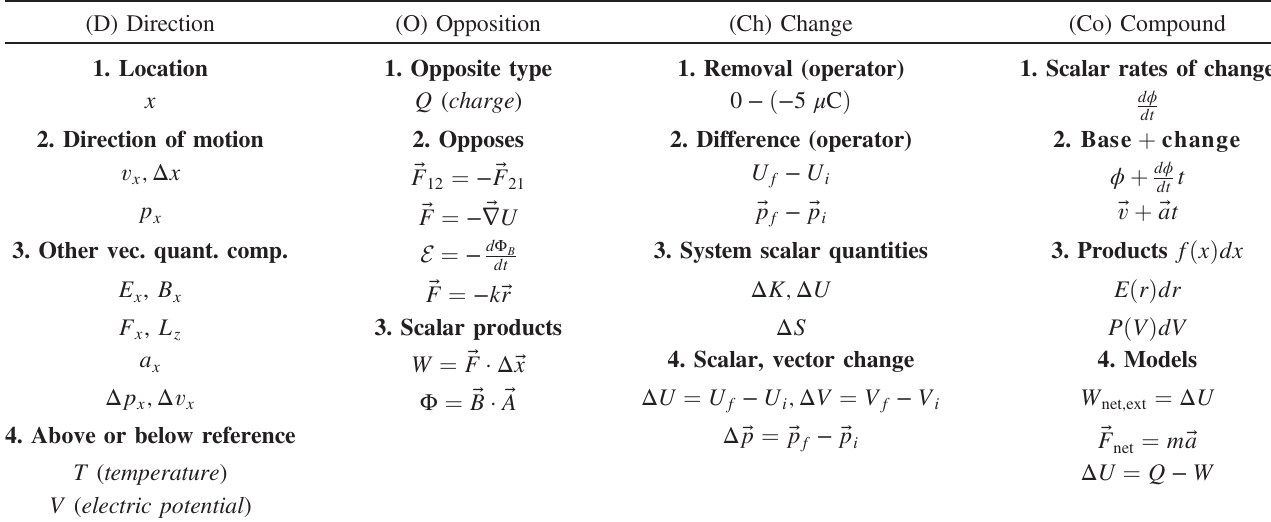
TABLE II. First version of the natures of negativity in introductory physics. The top row includes the four natures. The subnatures are organized into groups, shown bolded in the table. Some groups contain only one subnature. (D) Direction (O) Opposition (Ch) Change (Co)